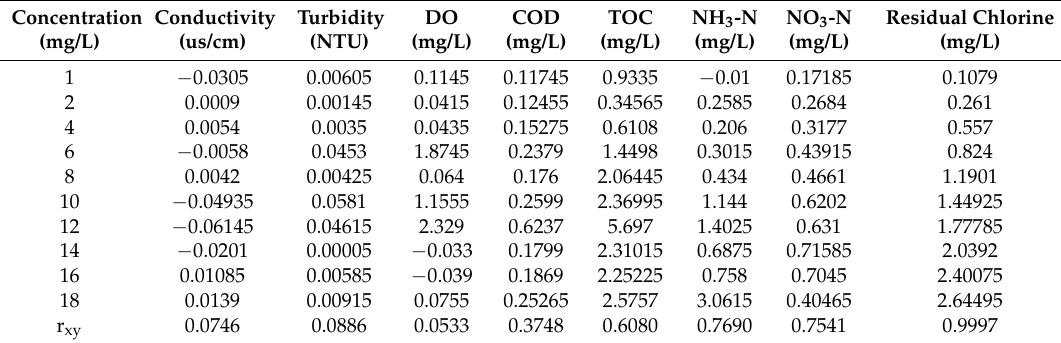
Table 3. Relative responding values and Pearson correlation coefficients (potassium ferricyanide, the 1st